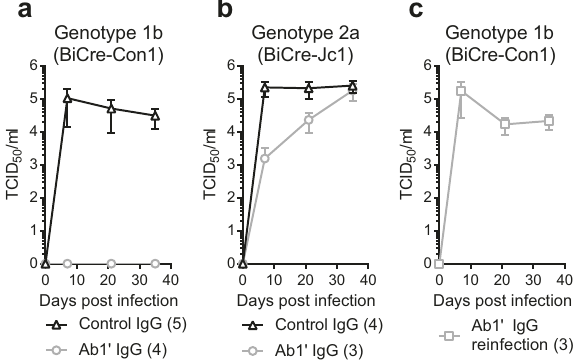
Fig. 6 B2.1 A protects against HCV challenge. HCV titers from human liver chimeric mice injected with control IgG or Ab1 ′ IgG and infected with ( a ) BiCreCon1 (Gt1b), ( b ) BiCreJC1 (Gt2a), ( c ) HCV titers from Ab1 ′ IgG-treated mice shown in ( a ) following reinfection with BiCreCon1. The number of mice in each group is shown in brackets. Values shown are the mean and